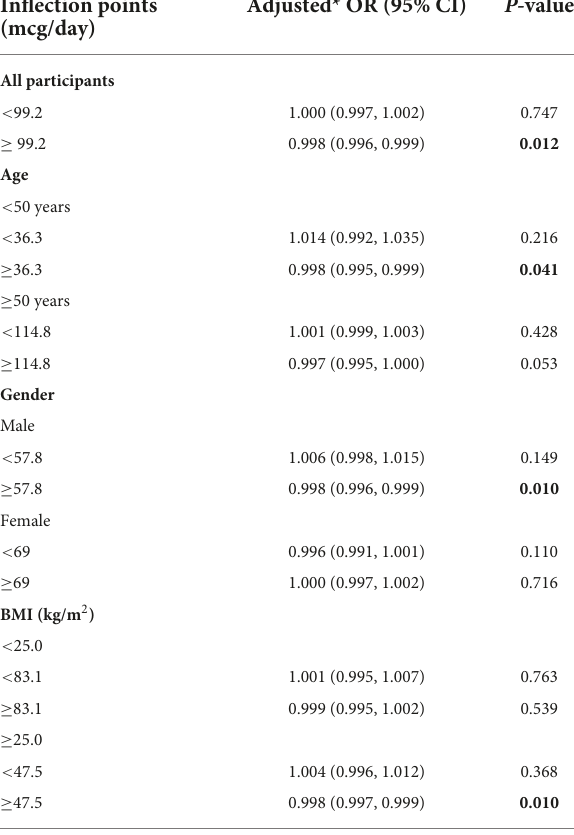
TABLE 3 Threshold effect analysis of dietary selenium intake on the prevalence of kidney stones using piece-wise linear